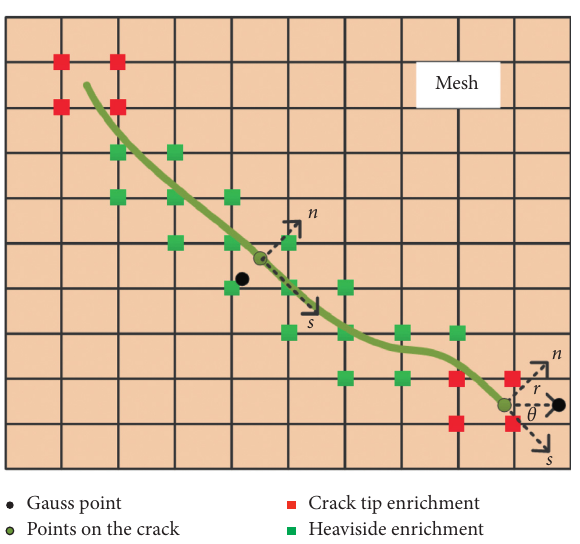
Figure 2: Illustration of normal and tangential coordinates for the crack.